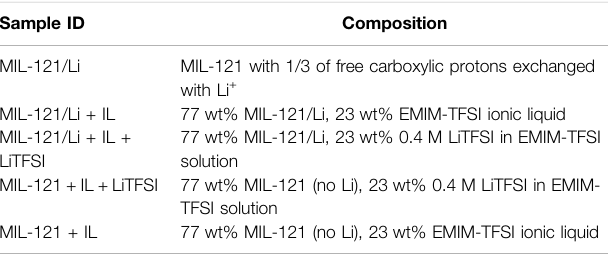
TABLE 1 | Sample abbreviations and compositions of the samples prepared and investigated. Sample ID Composition